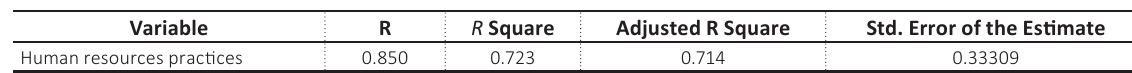
Table 3. Model summary for H1